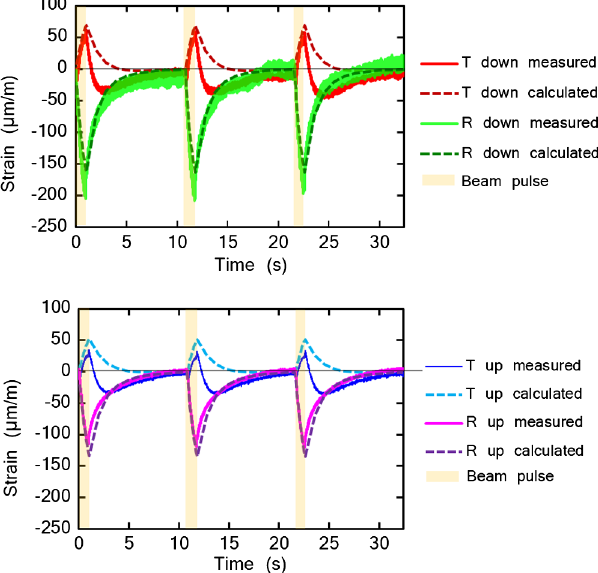
FIG. 18. Radial (R) and transversal (T) strain measured by two strain gauges placed in positions 01 (down) and 03 (up) of block 4 (see Fig. 12). Evolution during the first three consecutive beam pulses on target, at an intensity of 1 . 5 × 10 12 ppp and a repetition rate of 10.8 seconds. Comparison with the evolution predicted by means of FEM